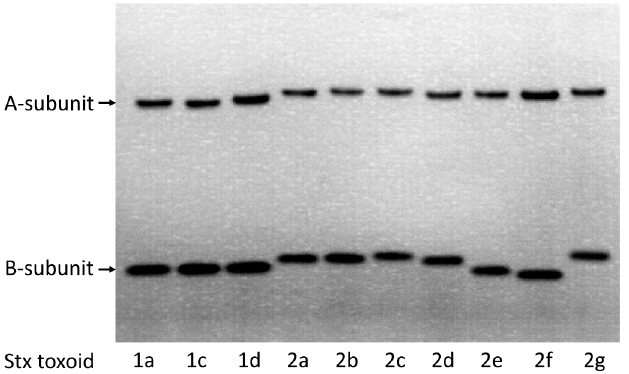
Fig 1. Exhibition of recombinant Stx toxoids following SDS-PAGE. Each lane was loaded with 1 μ g of toxoid purified by affinity column. The gel was stained with Simply Blue Safe Stain (Invitrogen). The 32 kDa A- subunit and 7-kDa B-subunit of toxoids are indicated by